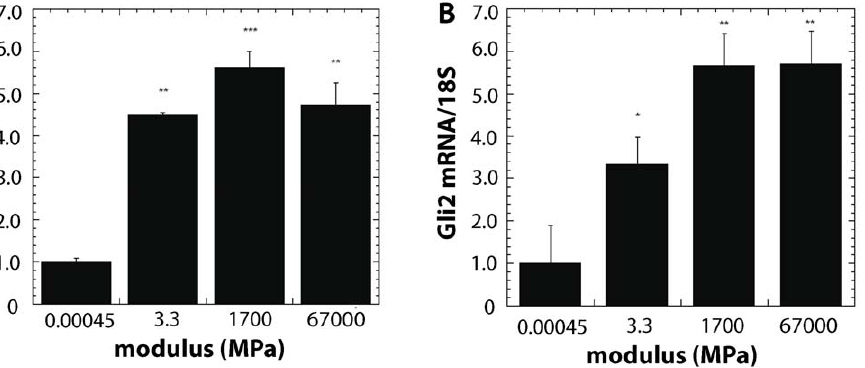
Figure 3. Expression of Gli2 and by MDA-MB-231 and RWGT2 cells increases with increasing substrate modulus. Expression of Gli2 mRNA normalized by 18S as measured by qPCR for (A) MDA-MB-231 and (B) RWGT2 cells on substrates of varying elastic modulus. Gli2 signaling increased 25-fold as the modulus increased from 3.3 to 1700 MPa (data not shown). *, # =p , 0.05; **, ## =p , 0.01; ***, ### =p , 0.005 compared to 0.00045MPa